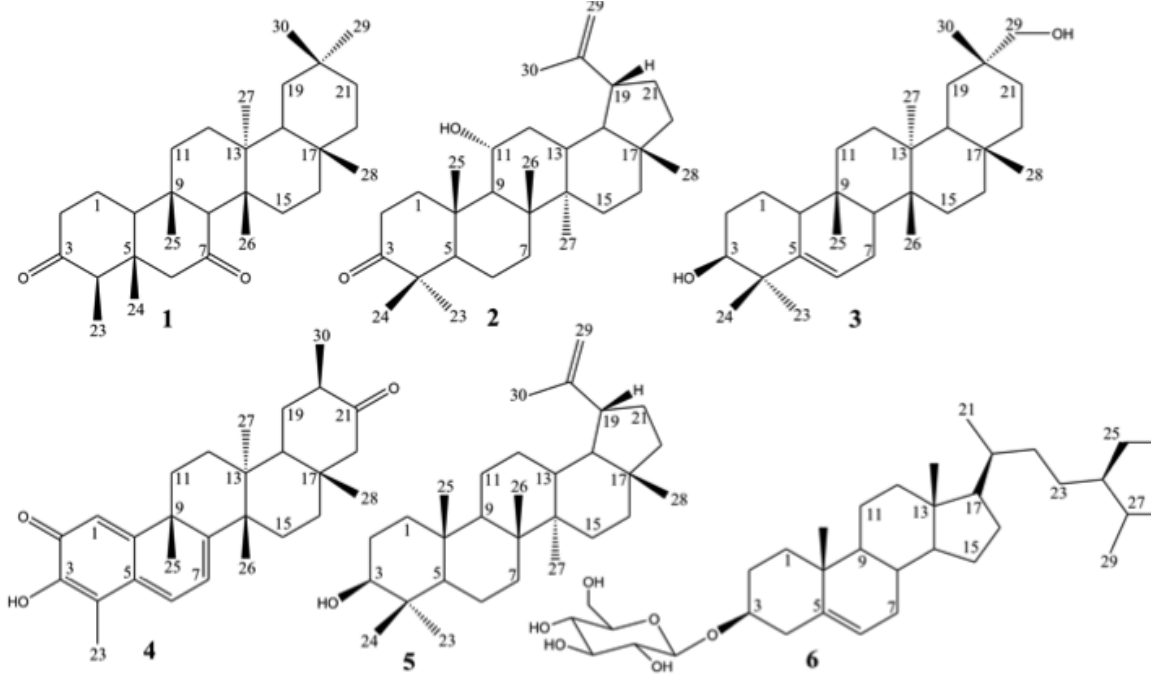
Figure 1 - Chemical structures of compounds isolated from extracts from Maytenus gonoclada